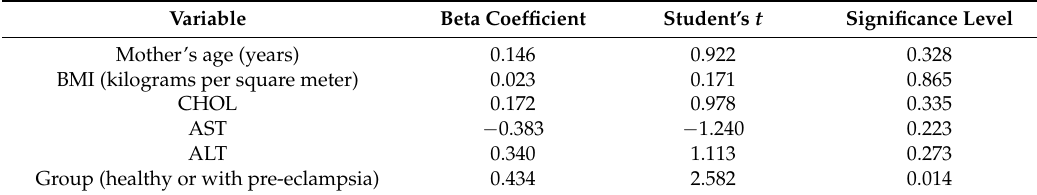
Table 5. Linear regression results regarding the right carotid artery intima–media thickness.